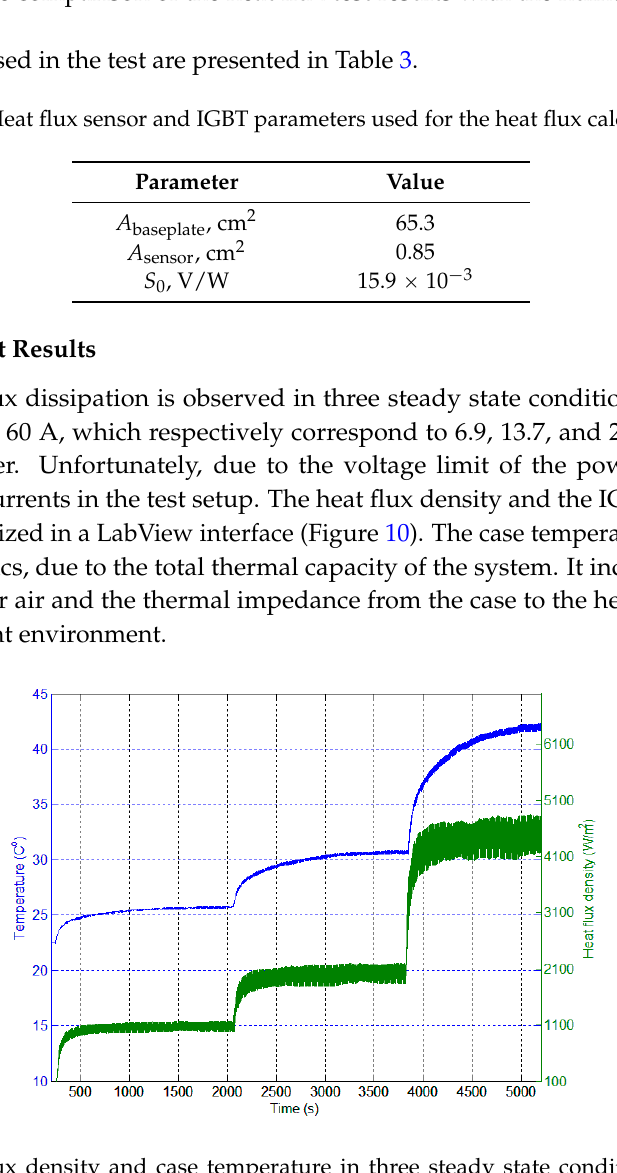
Figure 11. Heat flux at 0.1 Hz and 7 Hz with 15 A source current. The IGBT collector ‐ emitter voltage V ce and the collector current I c , measured within a 5 ms time to cover the IGBT switching are shown in Figure 12. The corresponding instantaneous and average power losses calculated based on V ce and I c and the measured heat loss Q are presented and shown to be equal. In Figure 13, the waveforms of the IGBT power losses modeled in PLECS (Figure 9), averaged by the switching frequency at 15, 30, and 60 A load current, are presented. Here, the power losses are formed as half ‐ waves of sinusoids. The average values at 15, 30, and 60 A are 6.9, 13.7, and 29.5 W, respectively.